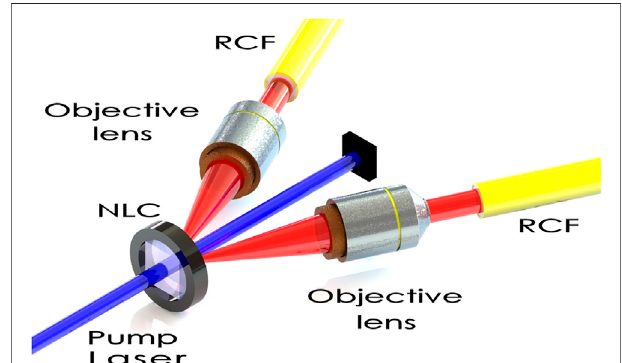
FIGURE 1 | Sketch of the basic idea. SPDC at a thin non-linear crystal (NLC) produces down-converted photon pairs, which are then coupled into ring-core fi bers. The angle between the down-converted beams and the pump beam is exaggerated in the Panel for visual clarity. In the calculations,itisassumedtobesmallenoughsothatthesetupcanbetreated as co-linear. The optical systems are such that the image plane of the crystal coincides with the entrance face of the fi bers, with appropriate magni fi cation